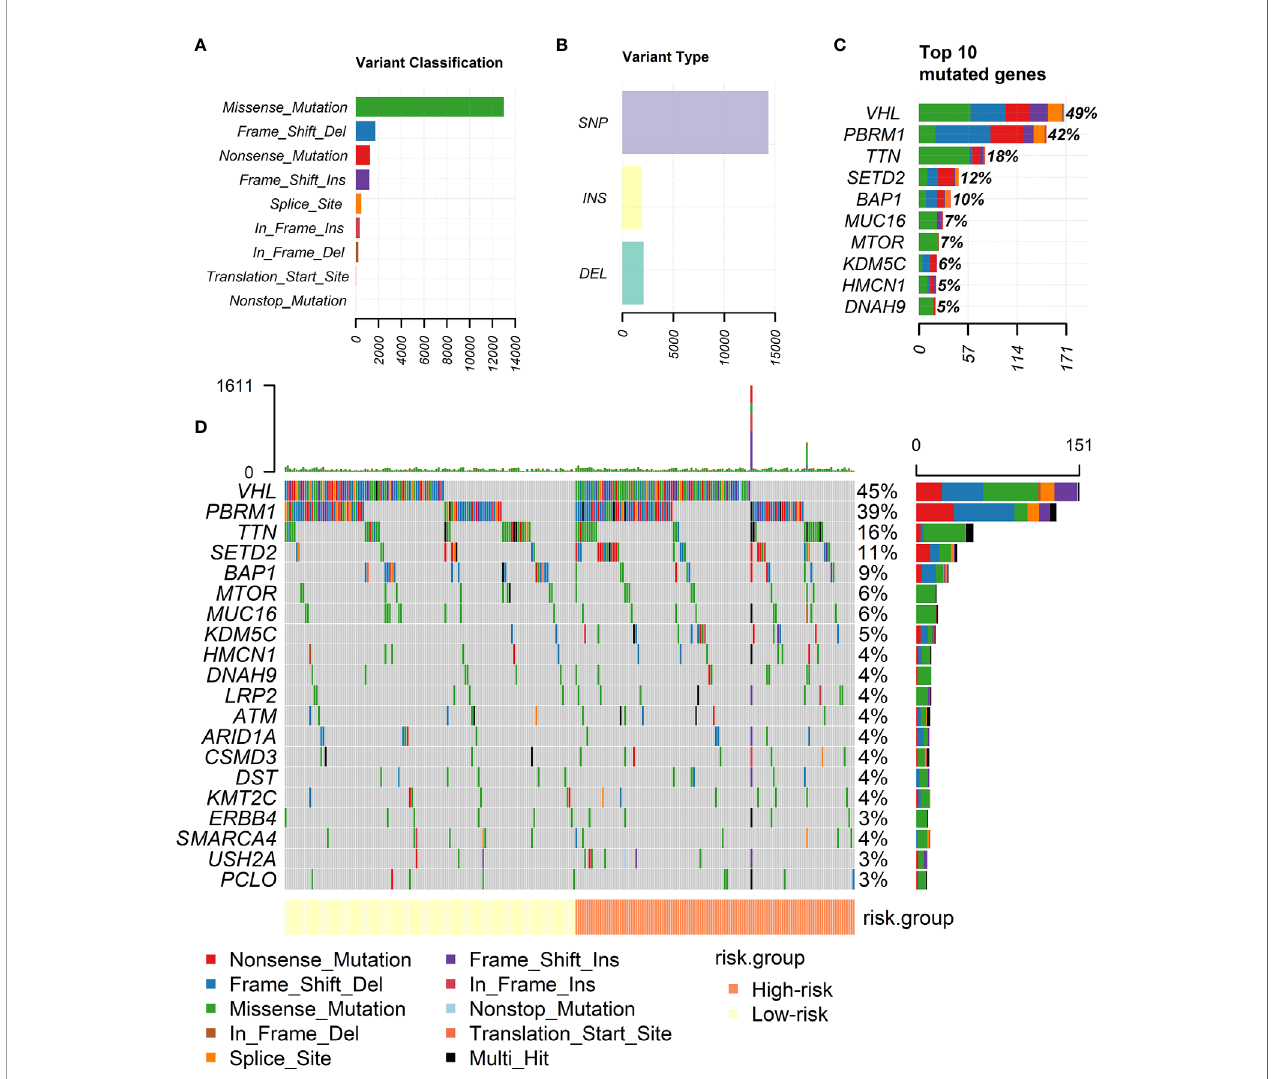
FIGURE 3 | Landscape of mutation pro fi les of ccRCC patients. (A) Classi fi cation of mutations by their effects. (B) Classi fi cation of mutations by different patterns. (C) Top 10 frequent mutations in ccRCC patients. (D) Mutation pro fi les of high-risk and low-risk groups divided by our risk